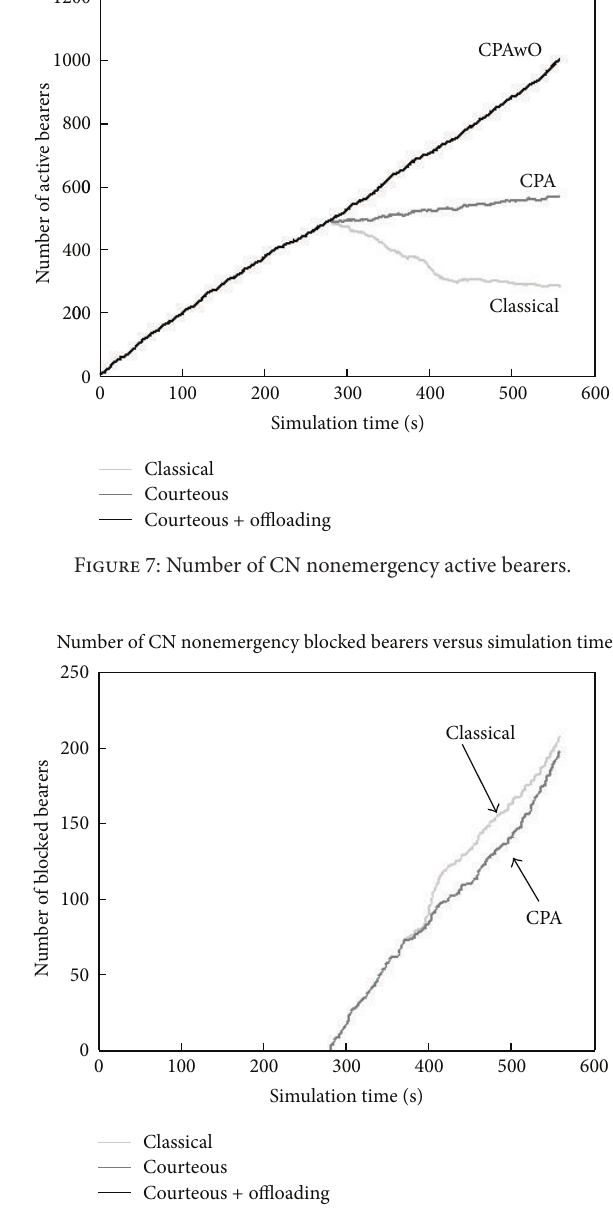
Figure 6: Number of CN emergency active bearers.